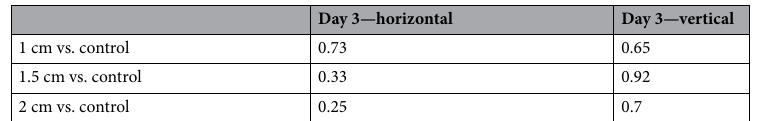
Table 3. Horizontal and vertical inhibition rates comparison between control and various distances of CHX— p